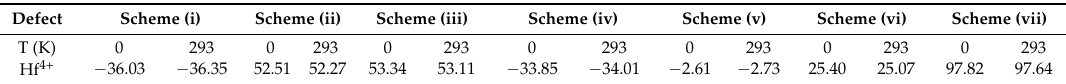
Table 6. Defect formation energies, in eV, for the bound defect.